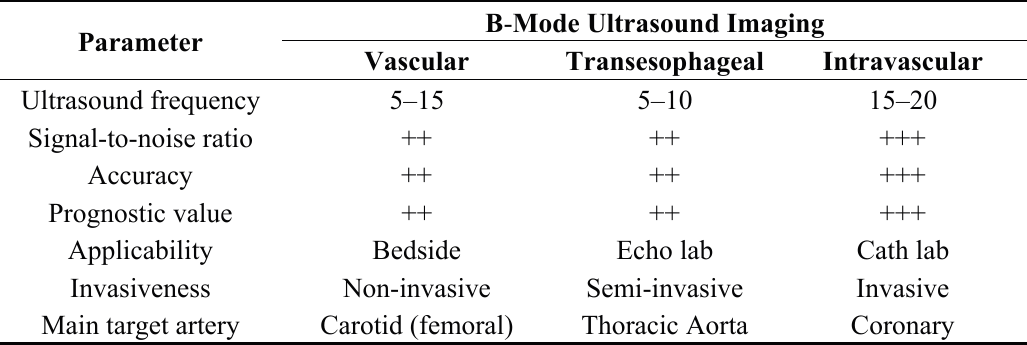
Table 2. Ultrasonic tissue characterization: